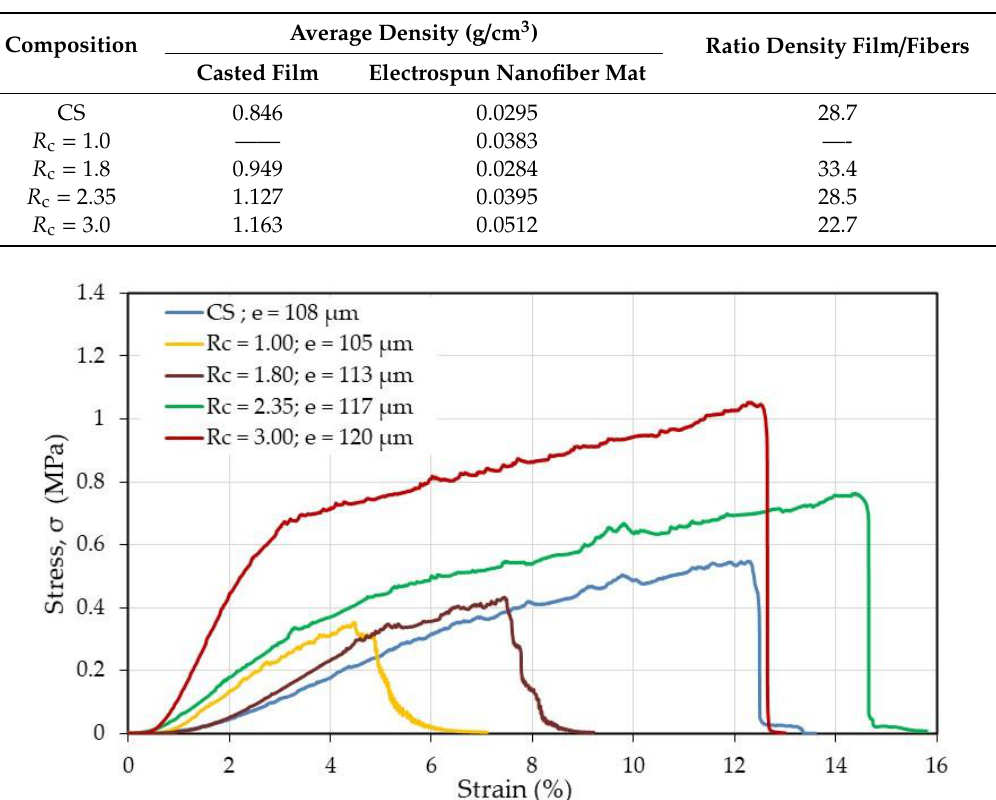
Figure 14. Mechanical behavior of chitosan and as-spun PEC fiber samples in dried state. Table 4. Morphological Characteristics of Films and Fibers Tested in Mechanical Experiments. Influence of the Charge ratio, R c.